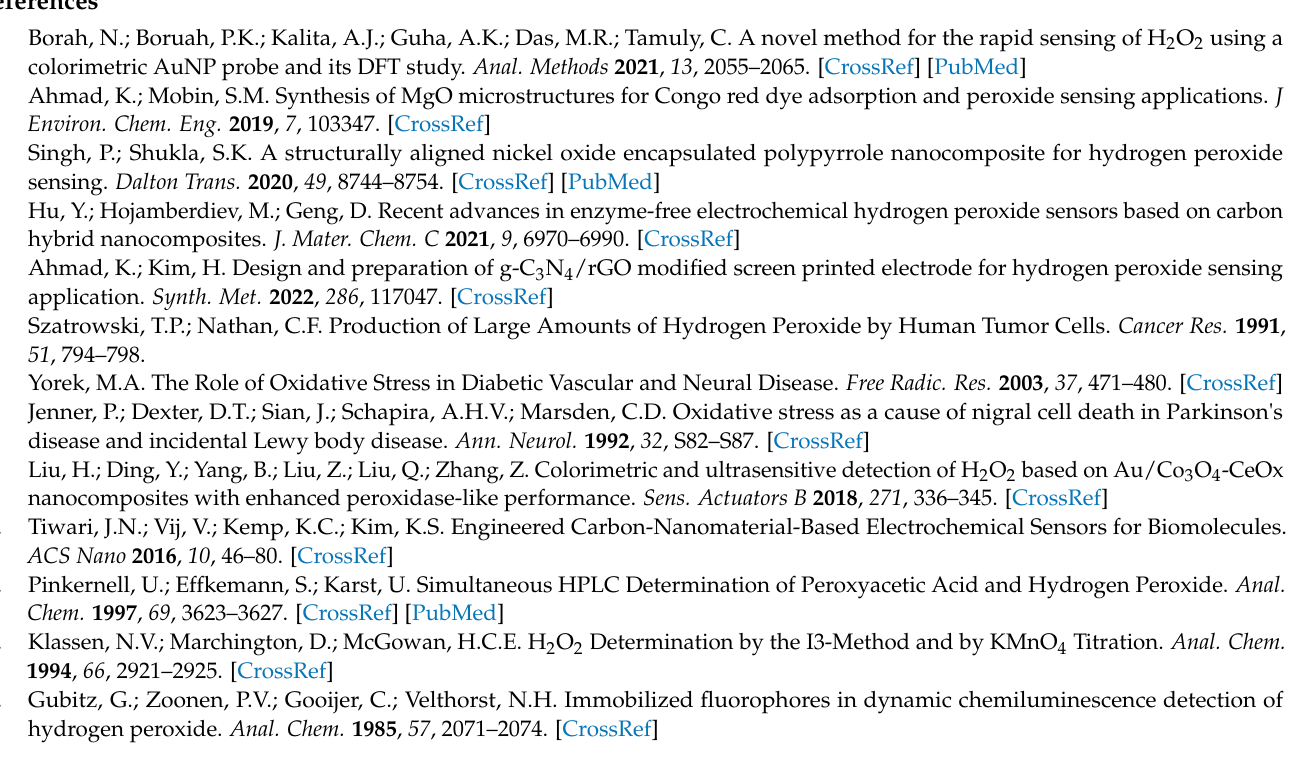
Figure S2: CV curves of the N-rGO/SPCE in presence of 0.01 mM H 2 O 2 in 0.1 M PBS of different pH (3,5,7,9, and 11) at scan rate of 50 mVs –1 . Figure S3: CV curves (a) of SPCE in presence of different concentration of H2O2 (0.01, 0.05, 0.1, 0.2, 0.3, 0.4, 0.5, 0.6, 0.8, and 1.0 mM) in 0.1 M PBS of pH 7.0 at scan rate of 50 mVs –1 and corresponding linear calibration plot (b) between peak current response versus concentration of H 2 O 2 . Figure S4: CV curves (a) of SPCE in presence 0.01 mM H 2 O 2 in 0.1 M PBS of pH 7.0 at different applied scan rates (50-500 mVs –1 ) and corresponding linear calibration plot (b) between peak current response versus square root of scan rate. Figure S5: LSV curves of SPCE in absence (black) and presence (red) of interfering molecules (glucose, chlorophenol, hydrazine, uric acid, urea, dopamine, ascorbic acid, and nitro-phenol) in 0.05 mM H 2 O 2 in 0.1 M PBS of pH 7.0 at scan rate of 50 mVs –1 . Figure S6: Chronoamperometry curve (a) of N-rGO/SPCE in presence of different concentration of H 2 O 2 . Calibration curve (b) between current response versus concentration of H 2 O 2 . Figure S7: Selectivity test of N-rGO/SPCE towards H 2 O 2 determination in presence of various interfering